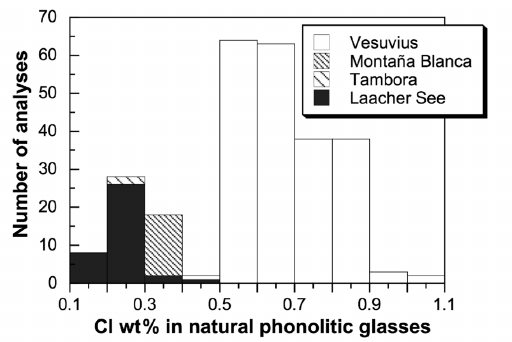
Fig. 8. Histogram of chlorine content of glass in- clusions and matrix glasses from phonolites. The da- ta are from the following volcanic systems: Vesuvius (Cornell and Sigurdsson, 1987; Mues-Schumacher, 1994 and unpubl.; Cioni et al. , 1995, 1998; Signorel- li and Capaccioni, 1999; Signorelli et al. , 1999), Tambora (Devine et al. , 1984), Montaña Blanca (Signorelli, unpubl.) and Laacher See (Harms and Schmincke,